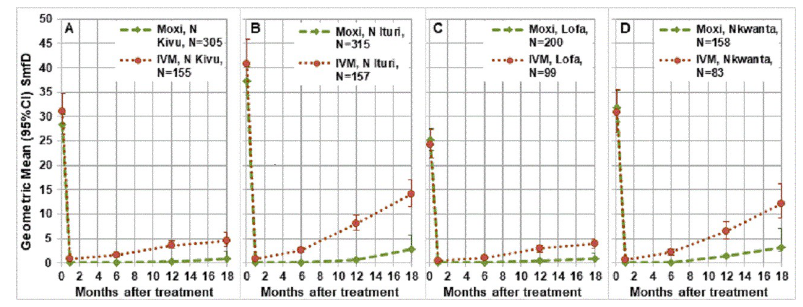
Fig 1. Geometric mean (95% CI) SmfD before and after treatment by study area. N Kivu Nord Kivu, N Ituri Nord Ituri, Lofa Lofa County, Nkwanta Nkwanta North district, N number treated (for number with follow up data at each time point, see Tables S5-S8 in S 1 File ).